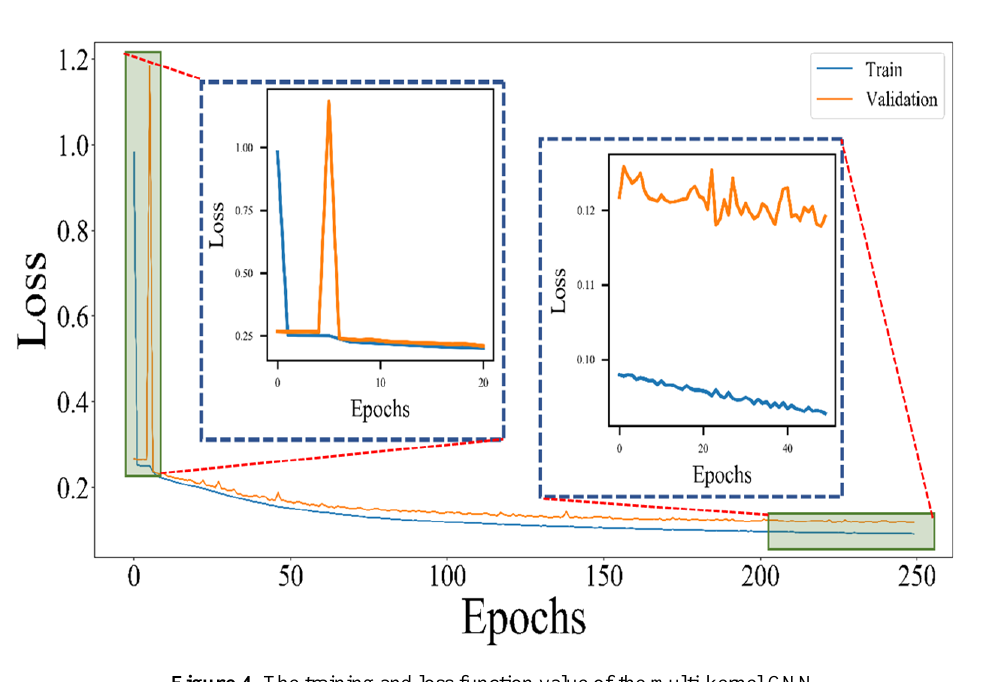
Figure 4 . The training and loss function value of the multi-kernel CNN.